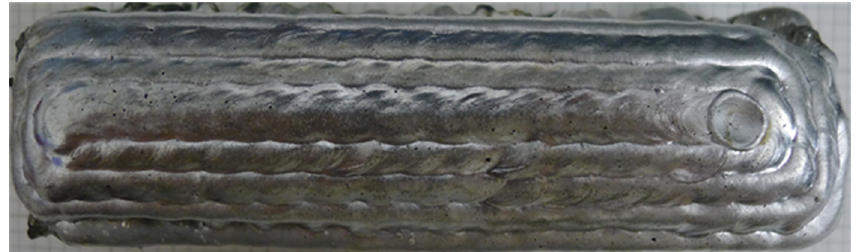
Figure 7. Example top surface of a 4943 printed specimen viewed in the direction of the